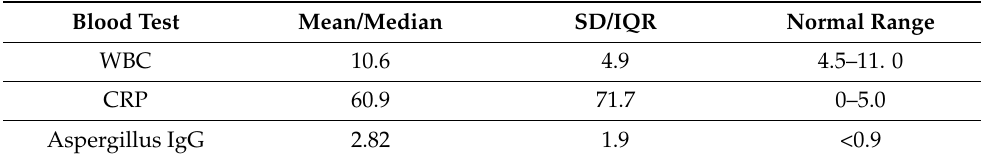
Table 2. The laboratory parameters of CPA